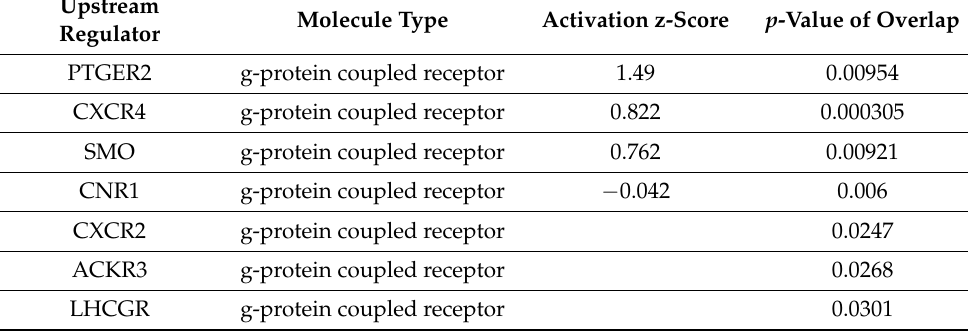
Table 6. The G-coupled protein receptors identified as Upstream Regulators by Ingenuity Pathway Analysis of the Gene Expression Omnibus dataset on unilaterally nephrectomized mice (GSE 53996).